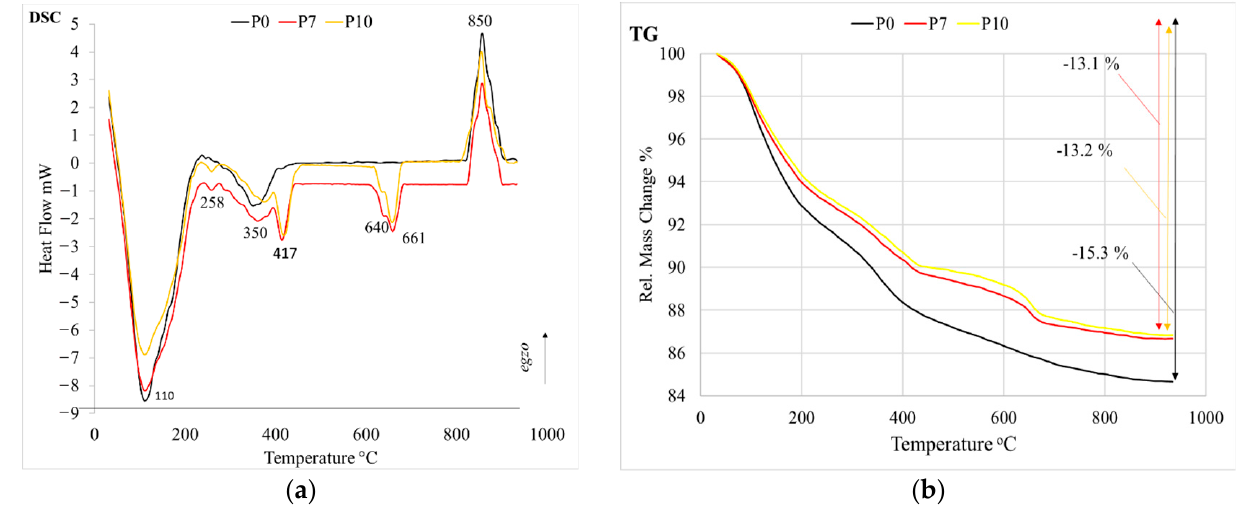
Figure 11. Differential scanning calorimetry ( a ) and thermogravimetric analysis ( b ) of porous alkali- activated slag at 28 days.